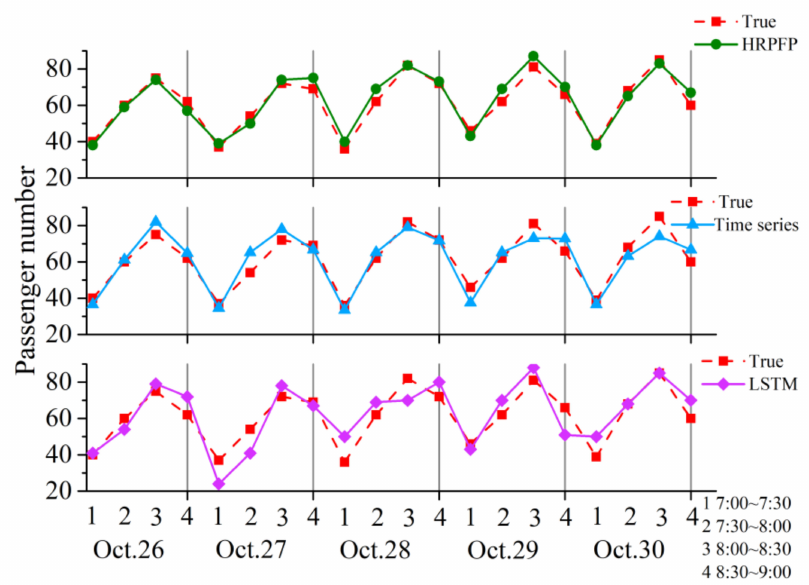
Figure 10. The comparison of three methods in passenger flow prediction using data from 7:00 to 9:00 for the 7 th station in line